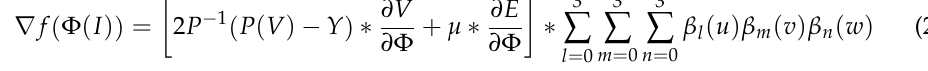
the joint histogram of V R and V T . In order to calculate the intensity difference between